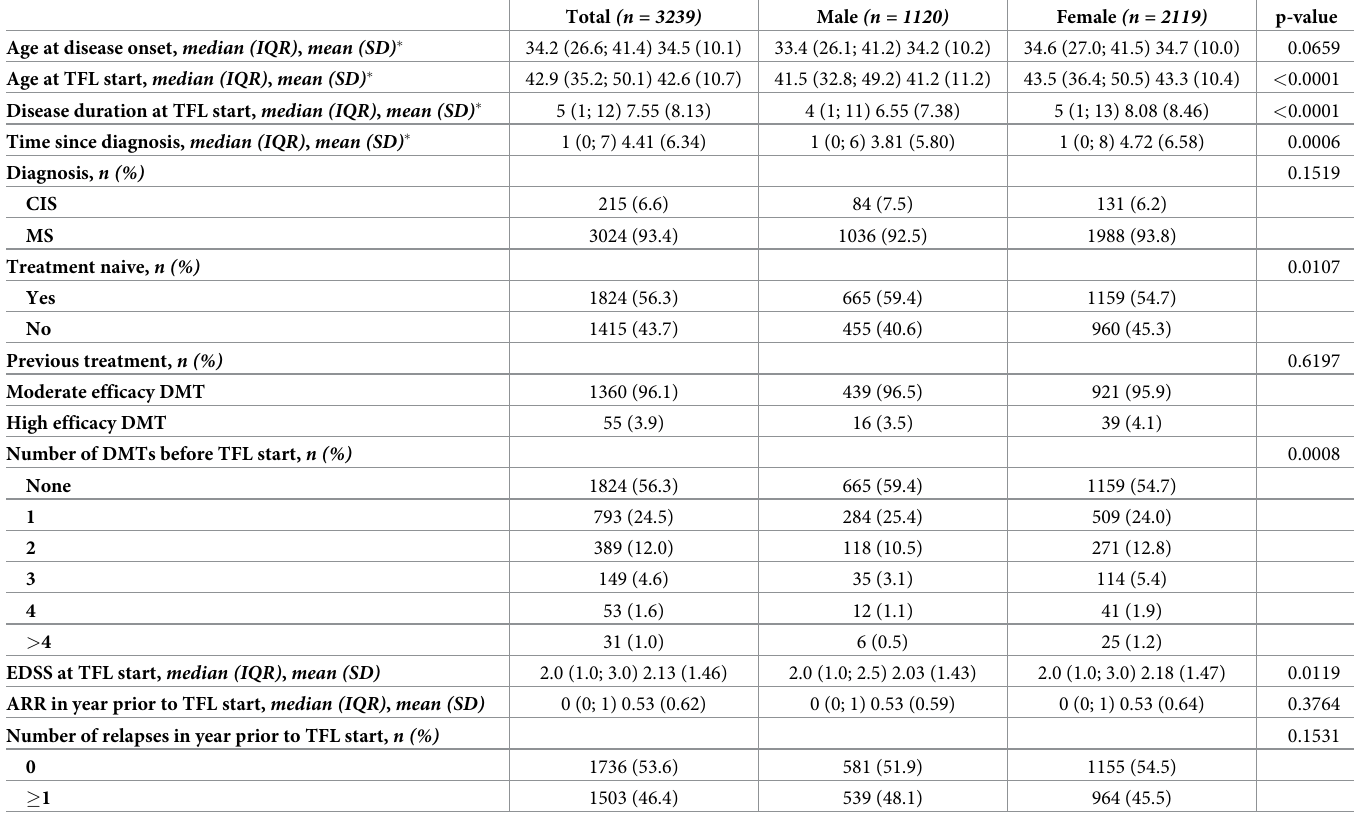
Table 1. Characteristics of the study population at teriflunomide treatment